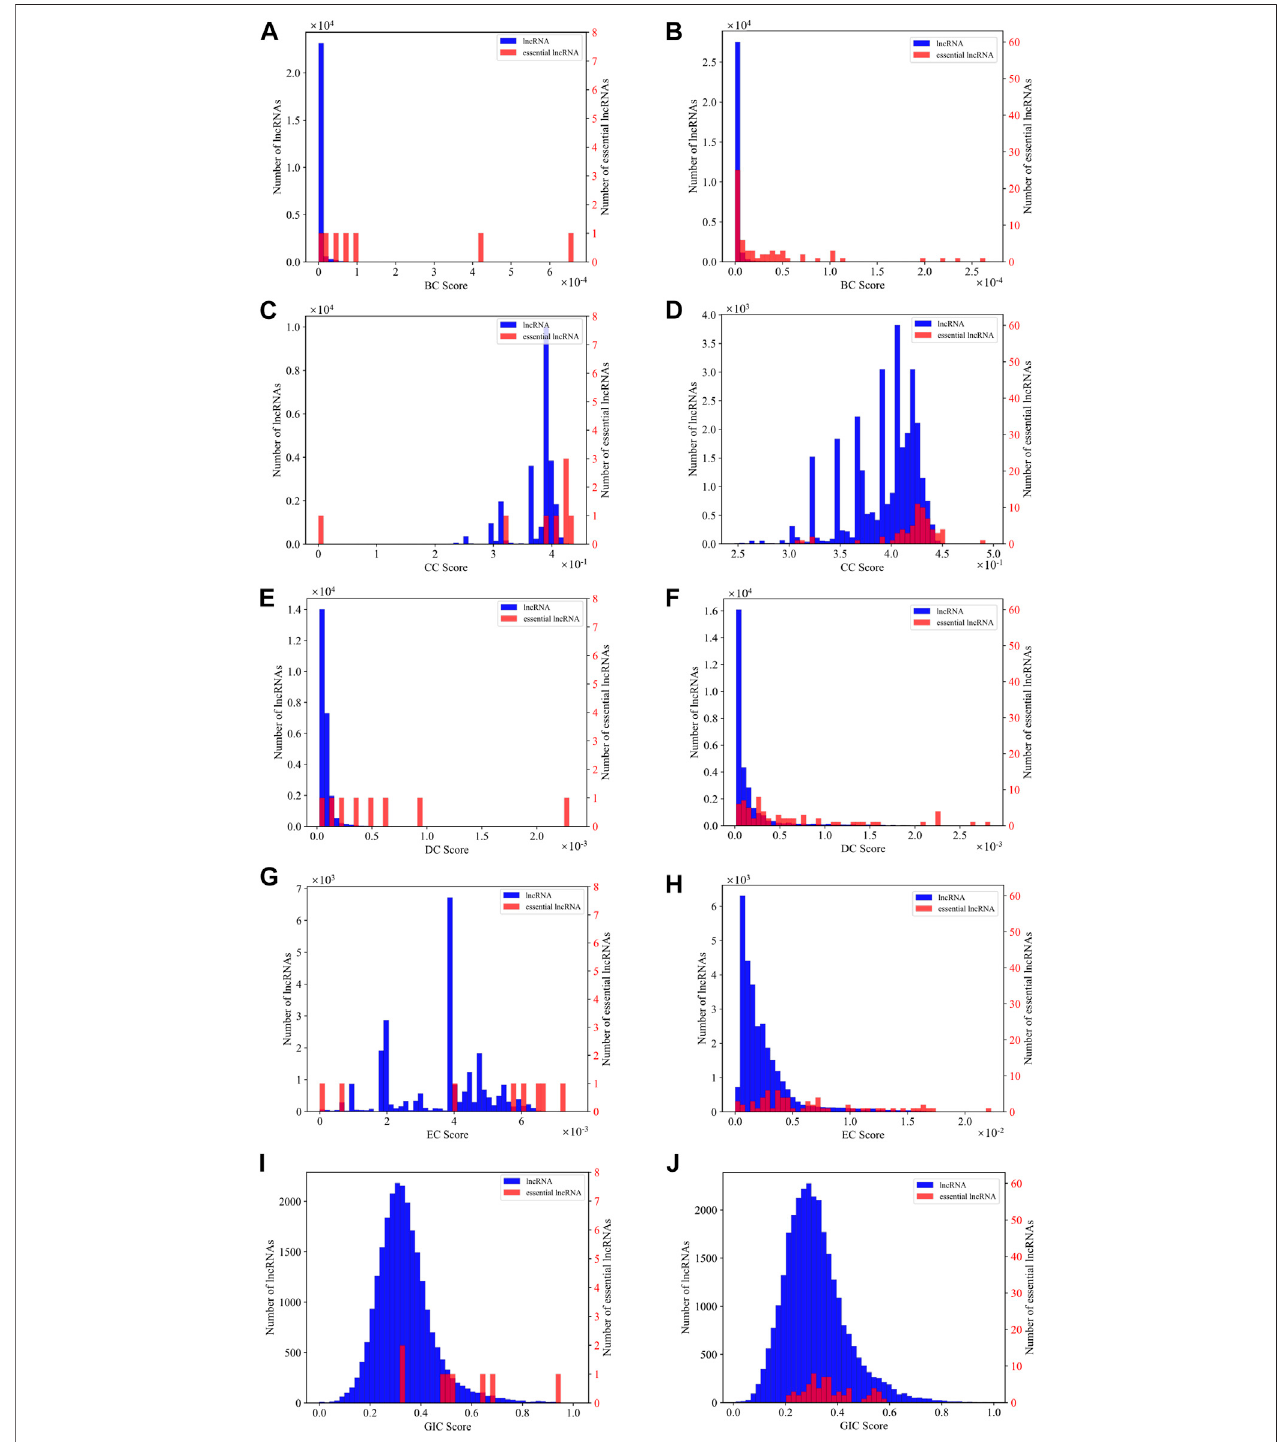
FIGURE6| ThedistributiondensityofdifferentcentralitiesandtheGICscoresonmousedatasetandhumandatasetrespectively. (A) ThedistributiondensityofBC on mouse dataset; (B) The distribution density of BC on human dataset; (C) The distribution density of CC on mouse dataset; (D) The distribution density of CC on human dataset; (E) The distribution density of DC on mouse dataset; (F) The distribution density of DC on human dataset; (G) The distribution density of EC on mouse dataset; (H) The distribution density of EC on human dataset; (I) The distribution density of GIC on mouse dataset; (J) The distribution density of GIC on human dataset. The red bars represent known essential lncRNAs, while the blue bars for all others. The vertical axis for the red bars are on the right side of the panel, while blue onleft.Whendrawingpanel(A),BCscoresofmouse HOTAIR and Xist aretoohightobeplottedinthescope.TheirBCvaluesare0.01and0.01.Whendrawingpanel(B), BC scores of human NEAT1 , MALAT1 , U1 are too far to be drawn in the scope. Their BC values are 0.03, 0.01 and 0.005.